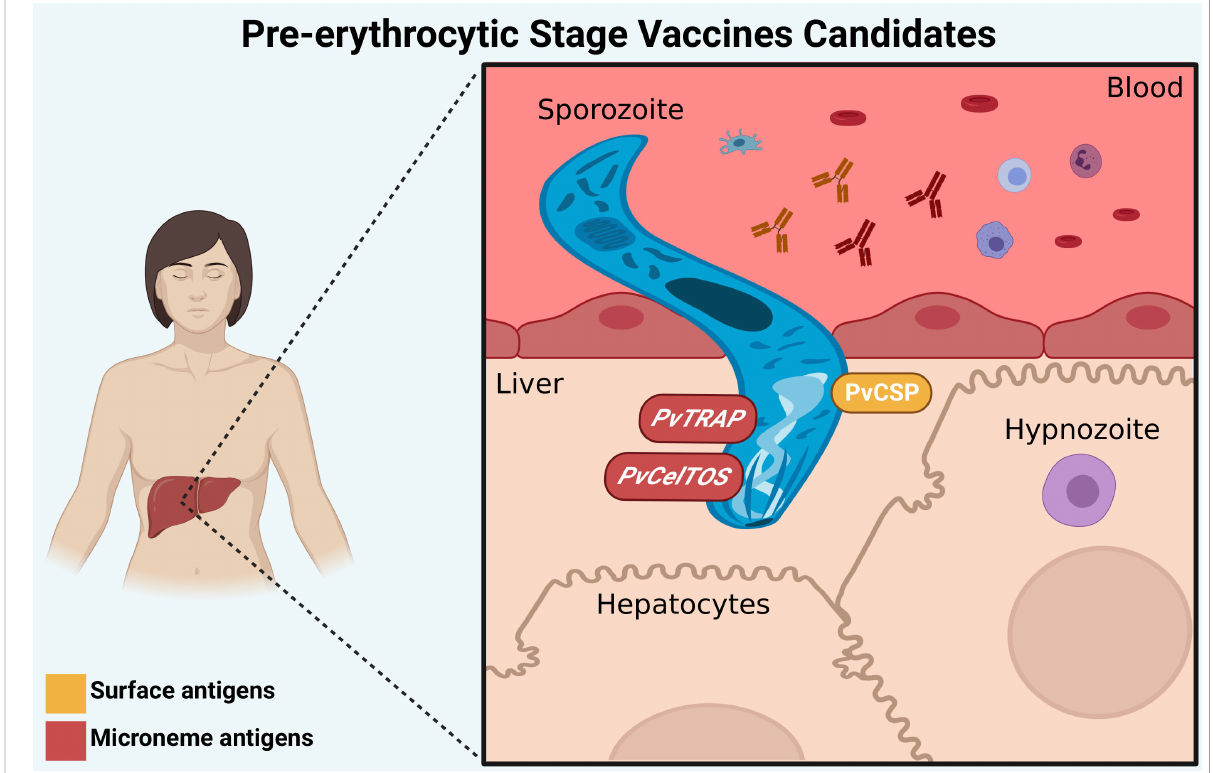
FIGURE 2 Preerythrocytic stage vaccine targets. The main candidates for PEV are PvCSP (surface antigen), PvTRAP and PvCelTOS (microneme antigens), which have a role in the invasion process of hepatocytes. Antibodies against these proteins (represented by “ Y shaped ” on the fi gure) can interrupt the invasion of P. vivax to hepatocytes and the development of liver forms of the parasite. Created with